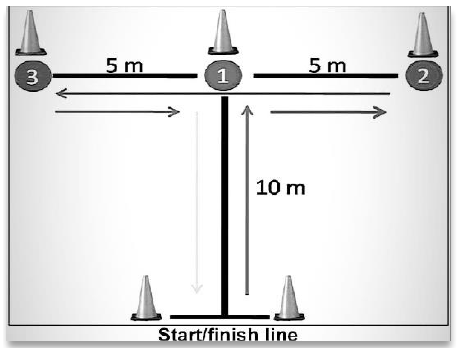
Figure 3. T-agility test. Figure 2. Unilateral squat (UT).